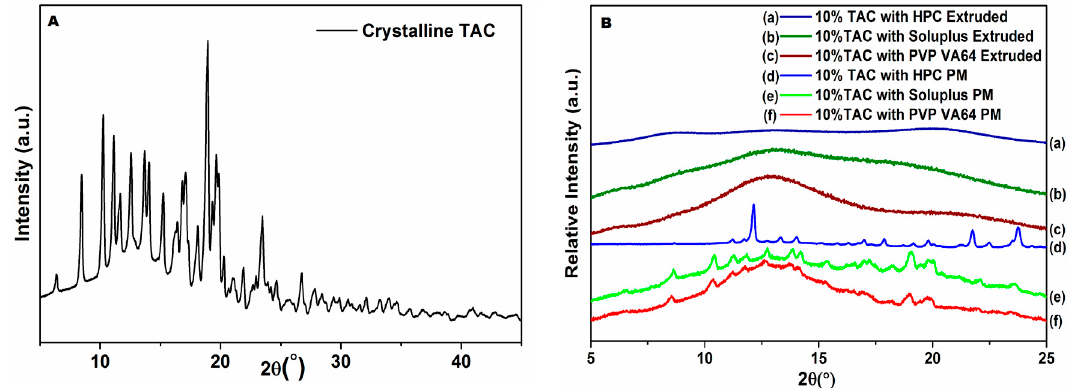
Figure 5. X-ray diffraction patterns of ( A ) TAC and ( B ) physical mixtures and solid dispersion containing 10% TAC.